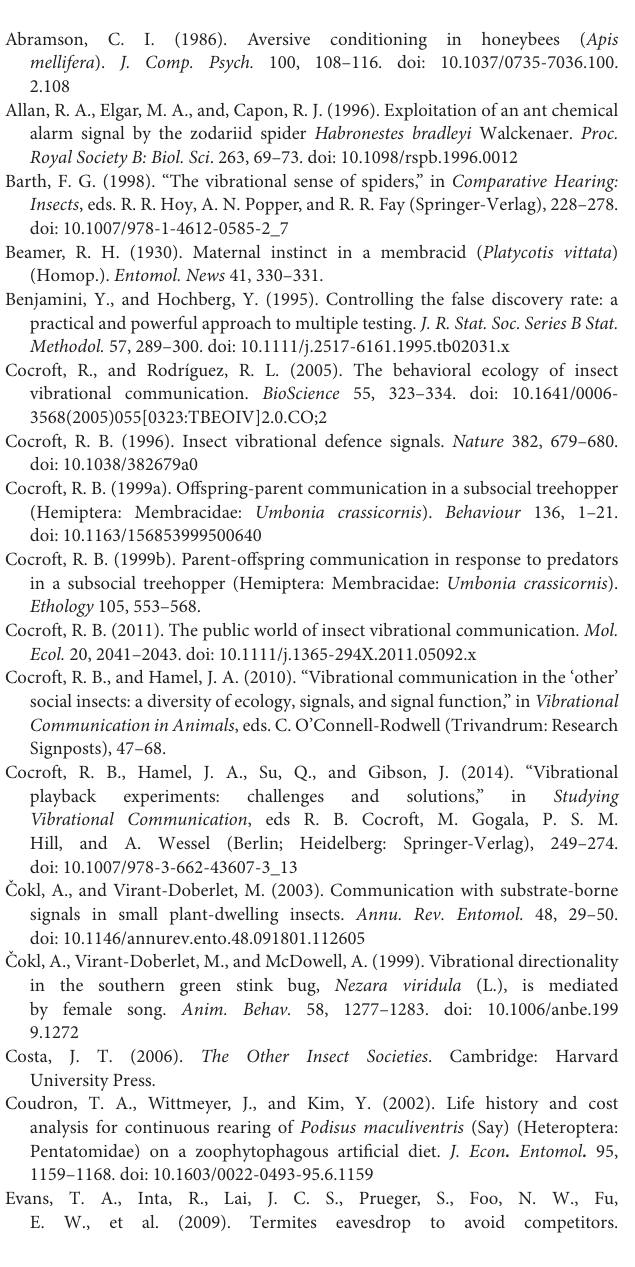
Frontiers in Ecology and Evolution |